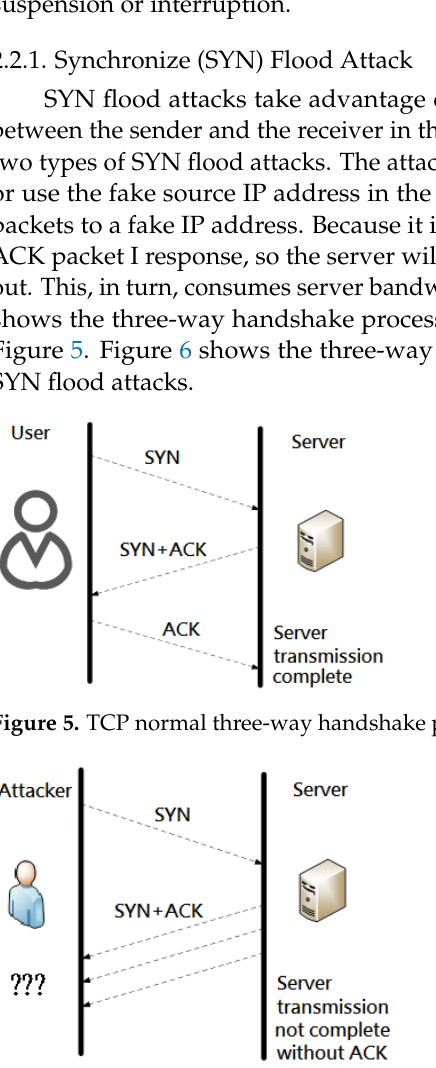
Figure 4. ICMP flood attack diagram.